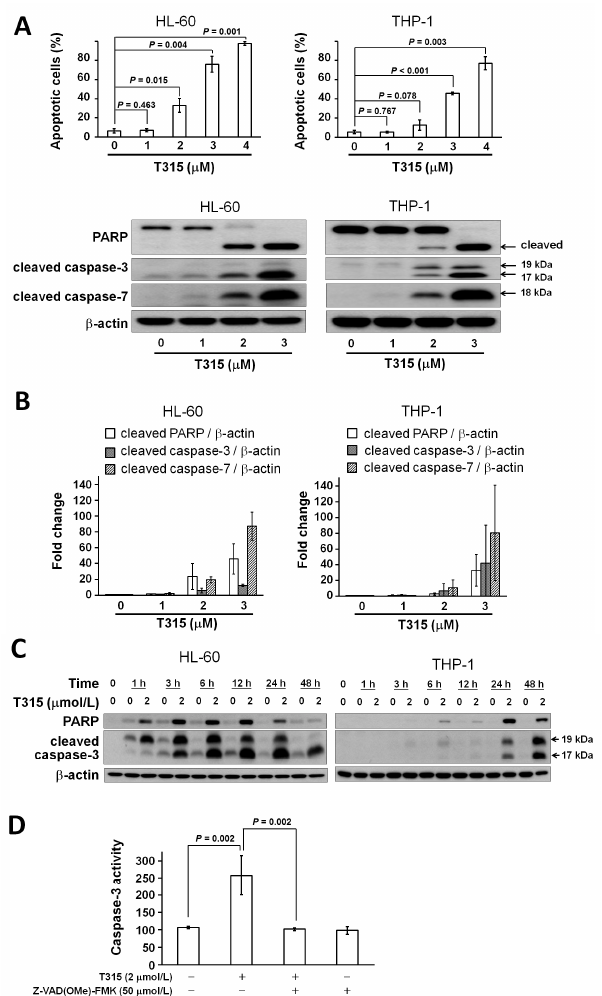
Figure 3. T315-mediated cytotoxicity is dependent on caspase activation and apoptosis. ( A ) T315 induced poly-ADP-ribose polymerase (PARP) cleavage and activation of caspase-3 and caspase-7 in HL-60 and THP-1 cells at 24 h. Protein extract of 20 µg from cell lysates were used for Western blot analysis; ( B ) Fold change of cleaved PARP/ β -actin, cleaved caspase-3/ β -actin, and cleaved caspase-7/ β -actin in treatment with T315 of 1, 2 or 3 µM compared with DMSO control ( n = 3); ( C ) Time course change of PARP cleavage and caspase-3 activation induced by T315 of 2 µM or DMSO control; ( D ) The increased caspase-3 activity in HL-60 cells treated with T315 for 24 h was rescued by pretreatment of 50 µmol/L Z-Val-Ala-Asp(OMe)-fluoromethyl ketone (Z-VAD(OMe)-FMK).